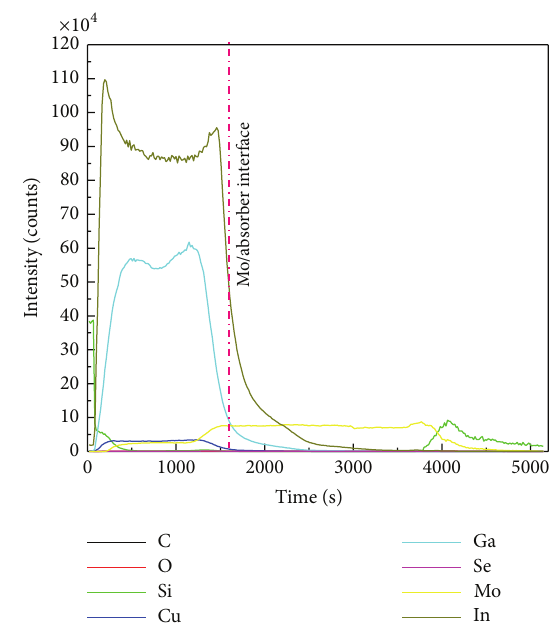
Figure 5: XPS depth profile for a single-phase CuIn 1− sample, clearly depicting the uniform distribution of the respective elements in the